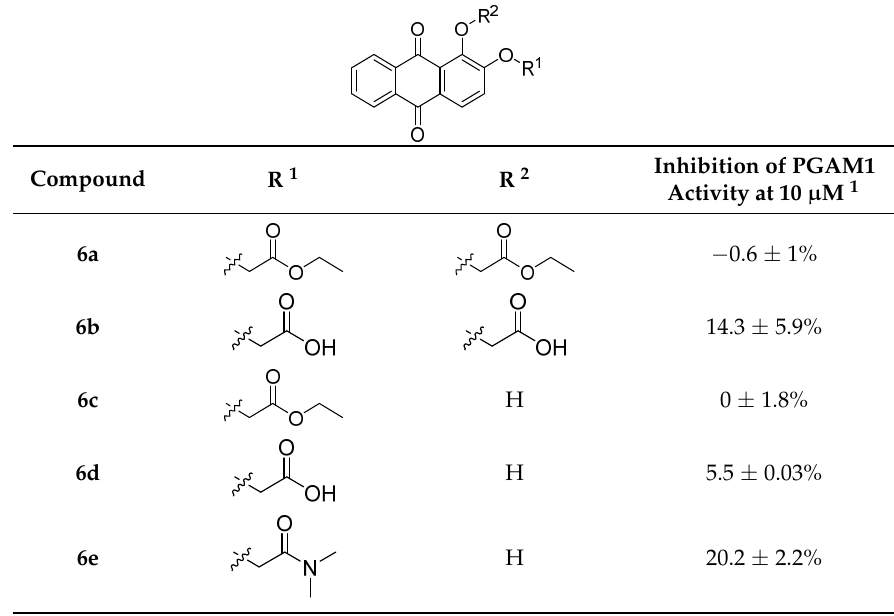
Table 2. Inhibition activity of compounds 9a – q towards PGAM1.